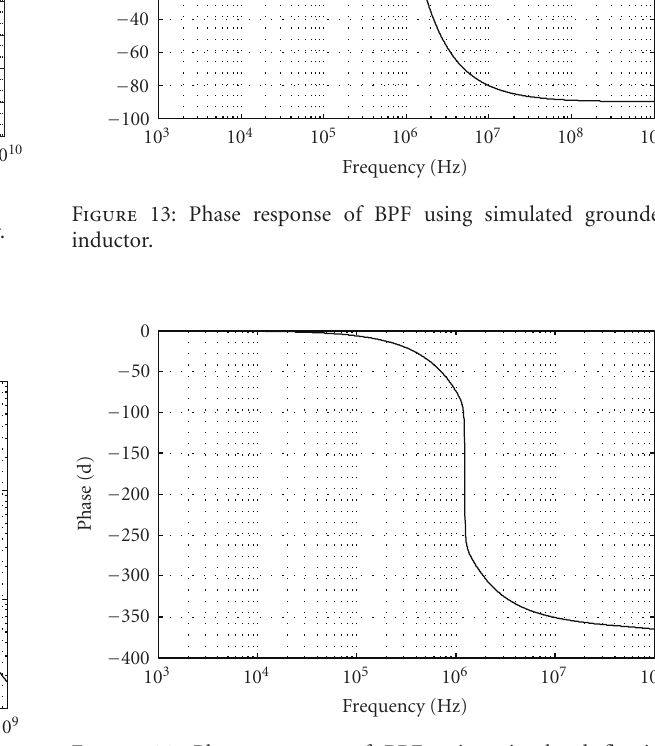
Figure 14: Phase response of BRF using simulated floating